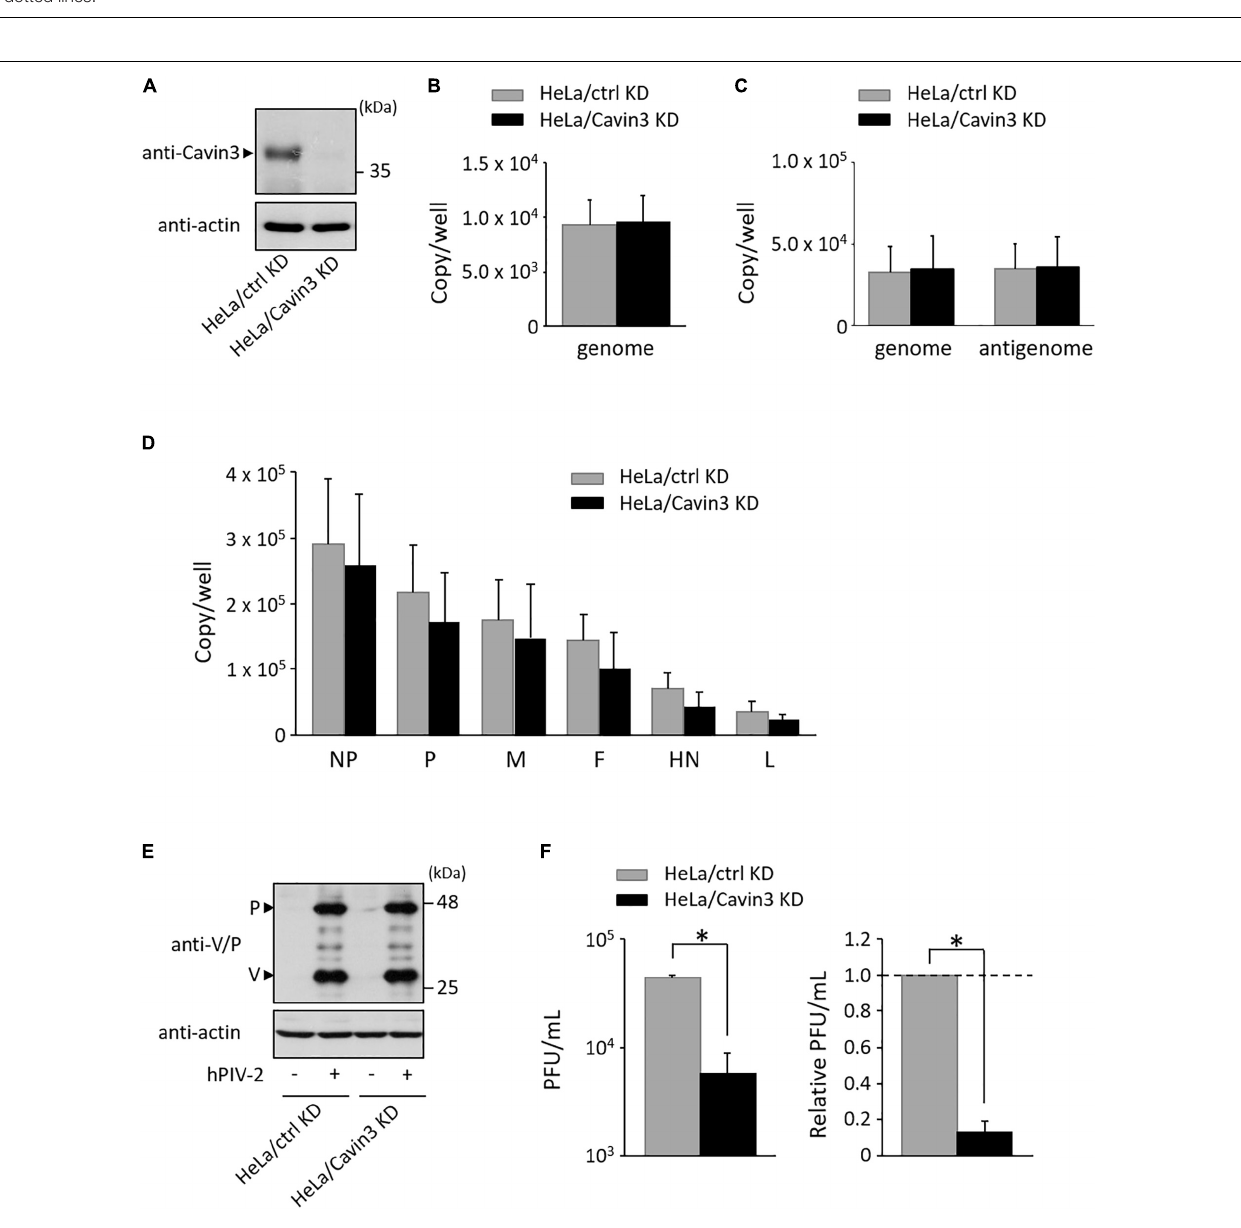
FIGURE 4 | Interactions between Cavin3 and hPIV-2 proteins. (A,C) COS cells were transfected with various combinations of the indicated plasmids. V/P indicates a deletion mutant composed of only common regions of V and P proteins. V W , V C1 , V C2 , and V C3 indicate V W178H / W182E / W192A , V C193 / 197A , V C209 / 211 / 214A , and V C218 / 221A , respectively. After 2 days, cell lysates were analyzed directly by immunoblotting (input). Immunoprecipitates with anti-V/P (A) or anti-FLAG mAb (C) were probed by anti-FLAG and anti-V/P mAbs. Double and single asterisks indicate immunoglobulin heavy chain and light chain, respectively. All experiments were performed at least three times independently. (B) Schematic diagram of full-length (FL) Cavin3 and its deletion mutants with C-terminal FLAG tag (F) was shown. Cavin3 contains leucine zipper (LZ), two PEST domains (PEST1 and PEST2), and phosphatidylserine-binding sites (PS). Deleted regions are indicated by the dotted lines.